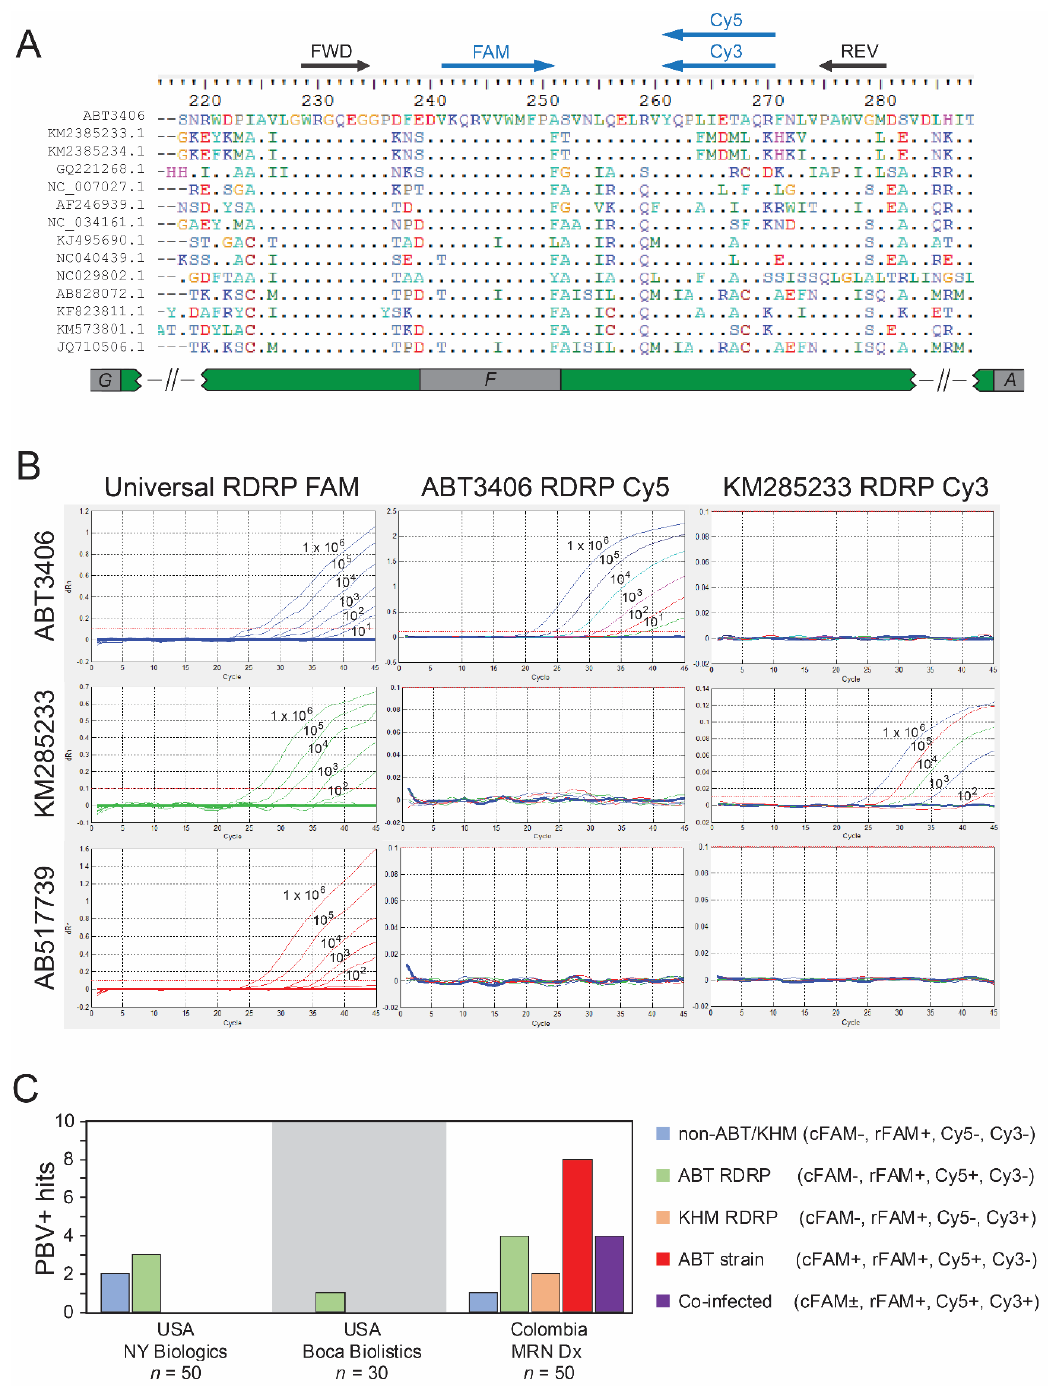
Figure 3. Quantitative PCR screen identifies PBV-positive patients hospitalized for acute respiratory illness. ( A ) Amino acid alignment of representative PBV from species PBVR1 for the qPCR target region in RdRp (polymerase motif F) and position of primers (FWD, REV) and probes (FAM, CY3, CY5) within the amplicon. ( B ) Amplification curves of serially diluted IVT positive controls (10 1 – 10 6 copies/mL) for ABT3406, KM285233, and AB517739 (rows 1 – 3) and their detection by FAM, CY5, and CY3-labeled probes (columns 1 – 3). The FAM probe binds to sequences conserved across PBV while CY5 and CY3 probes discriminate strains. Detection of ABT3406 capsid IVTs is shown in Supplemental Figure S2. ( C ) Results of RT-qPCR screen of 130 patients hospitalized with acute respiratory symptoms. Sputum was sourced from NY Biologics (NY, USA; n = 50), Boca Biolistics (Florida, FL, USA; n = 30) and MRN Diagnostics (Colombia, South America; n = 50). PBV+ RT-qPCR probe reactivity profiles are indicated in the legend and histograms are colored